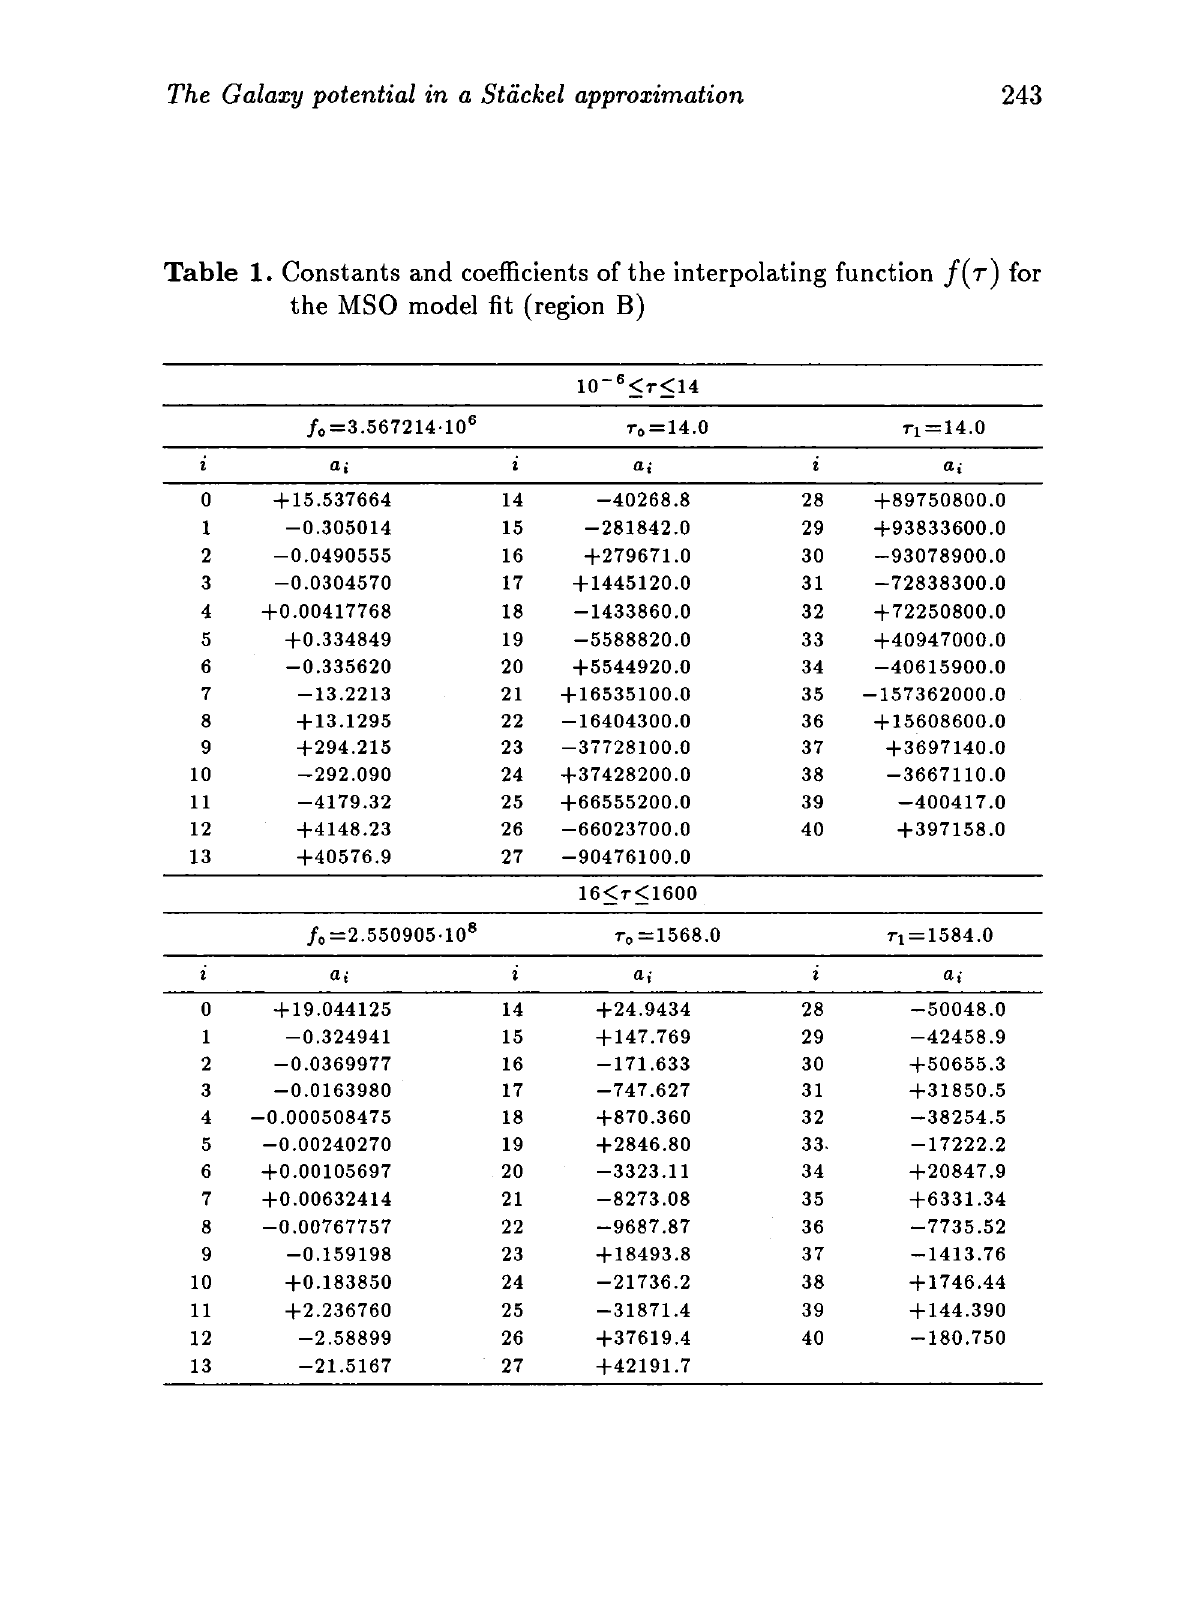
Table 1. Constants and coefficients of the interpolating function /( T ) for the MSO model fit (region